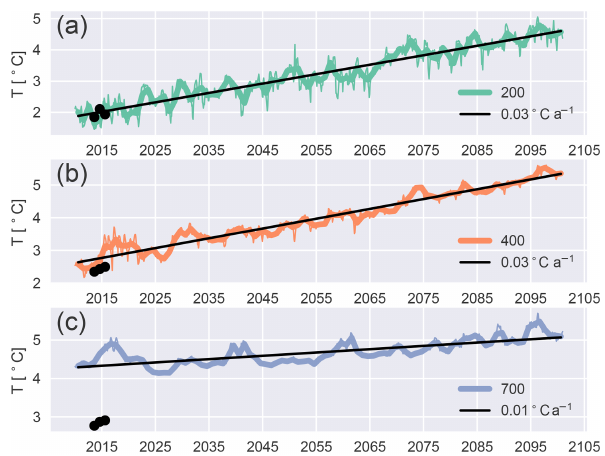
Figure 5. Monthly ocean temperature and centennial trend from the CMIP5 model MPI-ESM-LR in the closest grid cells to the fjord of Rink Isbrae that have a depth of at least (a) 200m, (b) 400m and (c) 700m. Black dots show CTD measurements at the same depth but inside the fjord.